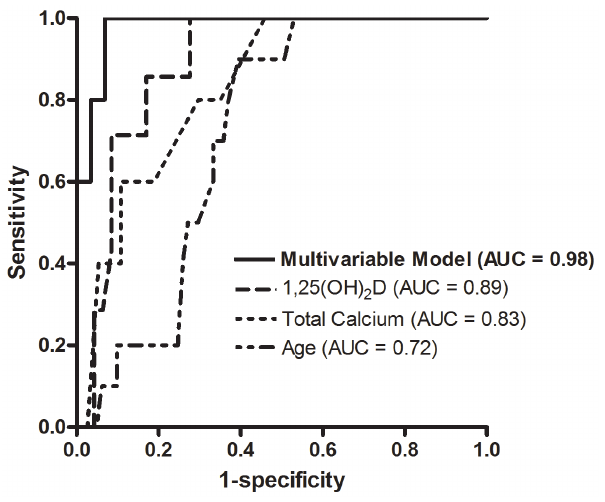
Figure 1. Receiver operating characteristic (ROC) curves for age, total calcium, 1,25-dihydroxyvitamin D (1,25(OH) 2 D) at hour 48, and the multivariable model including these 3 variables in discriminating survivors from non-survivors at 30 days after enrollment. AUC – Area under the ROC curve.